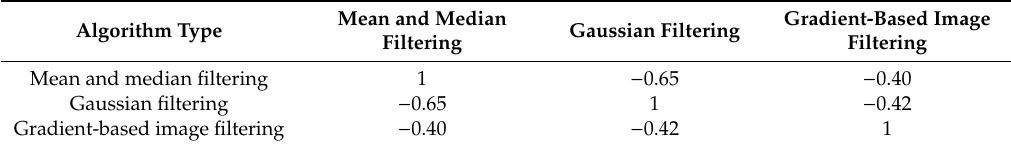
Table A8. The Pearson correlation coe ffi cients of the di ff erent edge smoothing algorithms using IS. It confirms that our sample accuracy was independent.